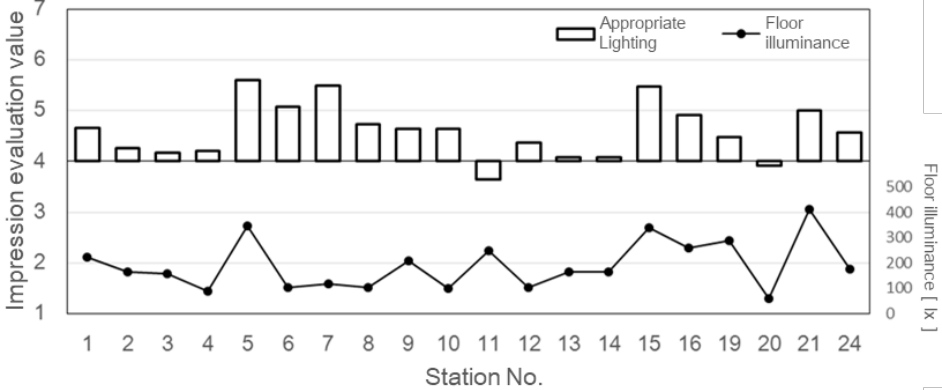
Figure 13. Results of impression evaluation of appropriate lighting and floor illuminance.